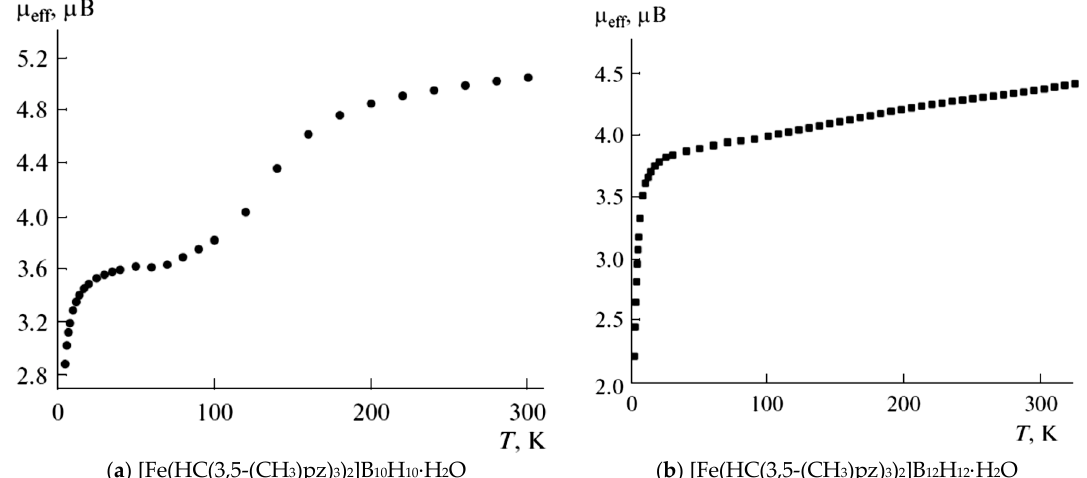
Figure 5. μ eff (T) plot: ( a )—incomplete SCO with exchange interactions between metal ions of an antiferromagnetic nature; ( b )—only exchange interactions between metal ions of an antiferromagnetic nature.